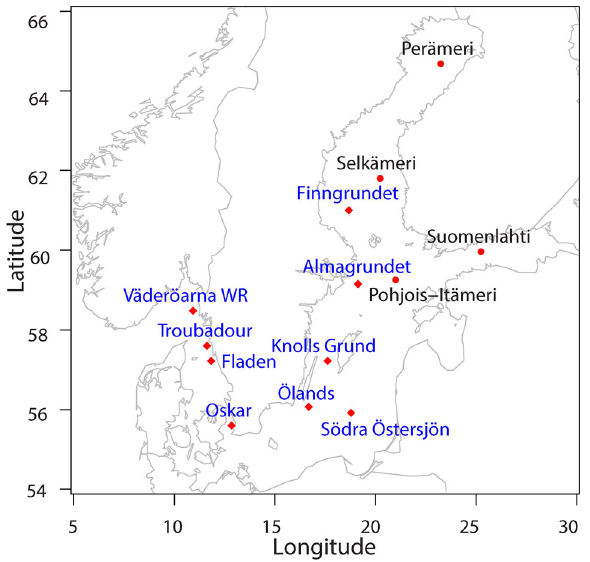
Fig. 2. Location scheme of the Baltic Sea and wave measurement locations used in the analysis. The SMHI stations are marked with diamonds, the FMI stations with